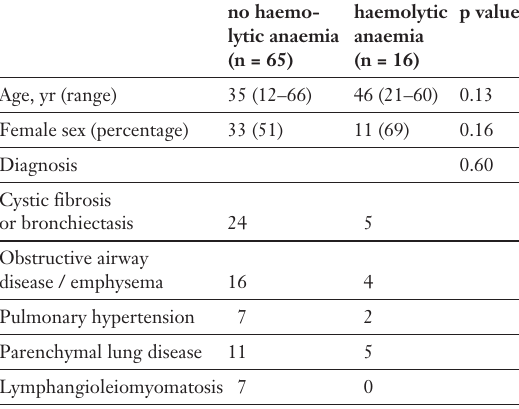
Baseline characteris- tics of the two study populations.